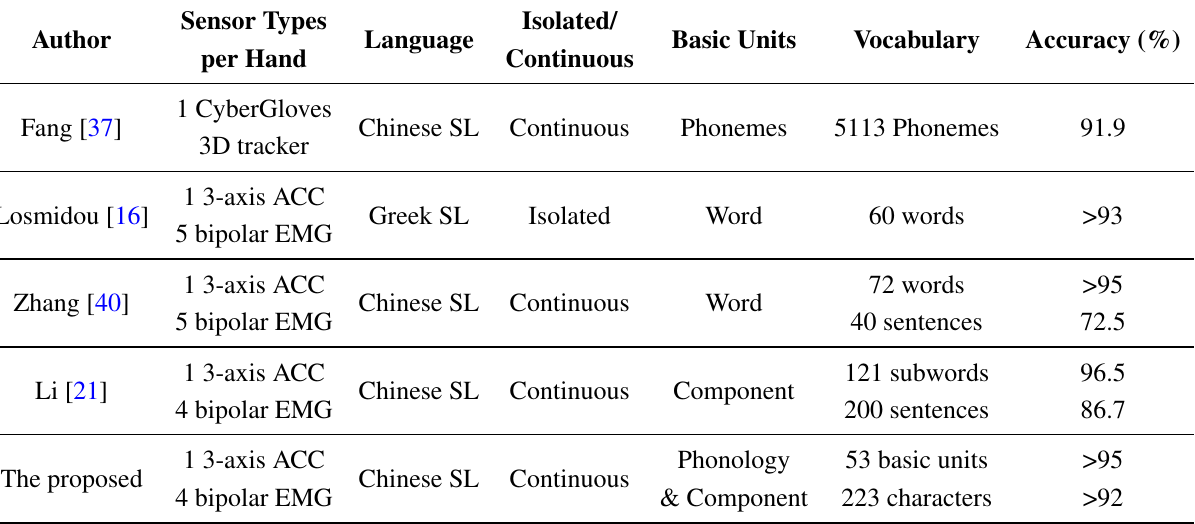
Table 2. List of some related